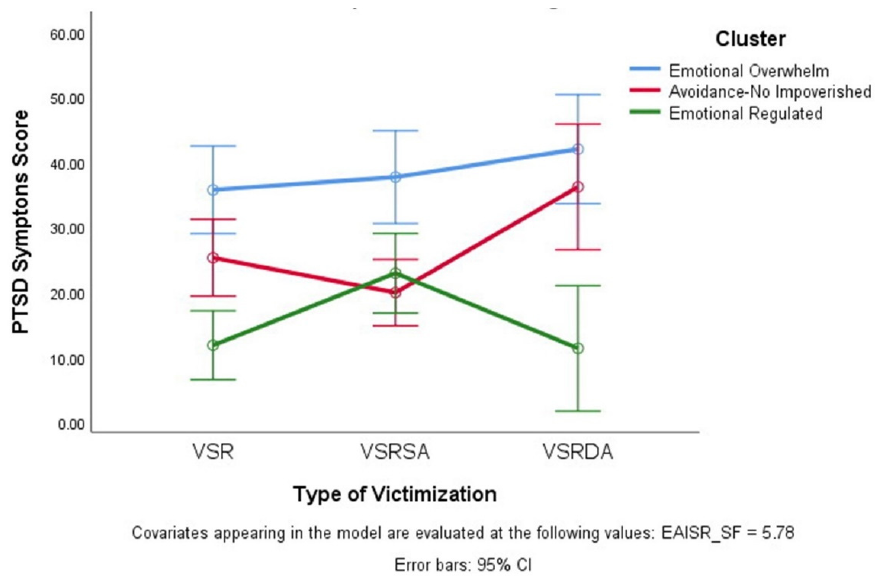
Figure 2. Symptoms of Post-Traumatic Stress according to type of victimization and profile of emotion regulation. VSR: victims with a single report, VSRSA: victims with several reports by the same aggressor; VSRDA: victims with several reports by different aggressors.